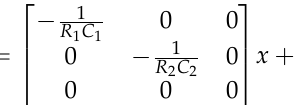
In Equation (2), x = Eulerian method is used to discretize the continuous state equation, and the discretized state equation and system output equation are shown in Equation